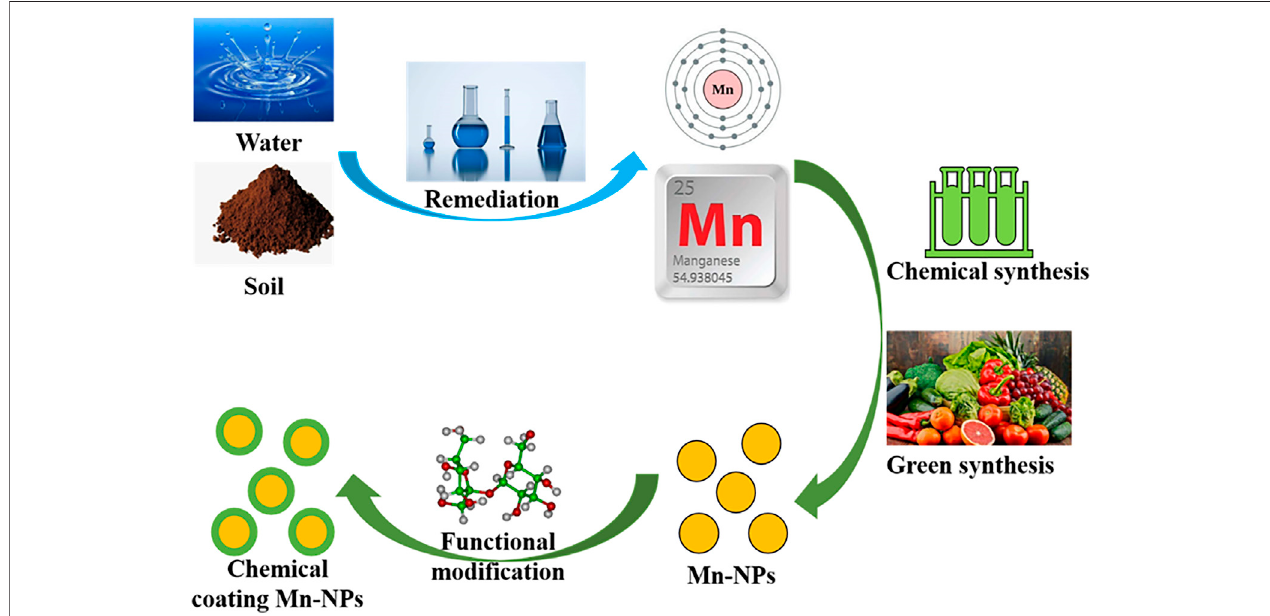
FIGURE 1 | Source and synthesis of